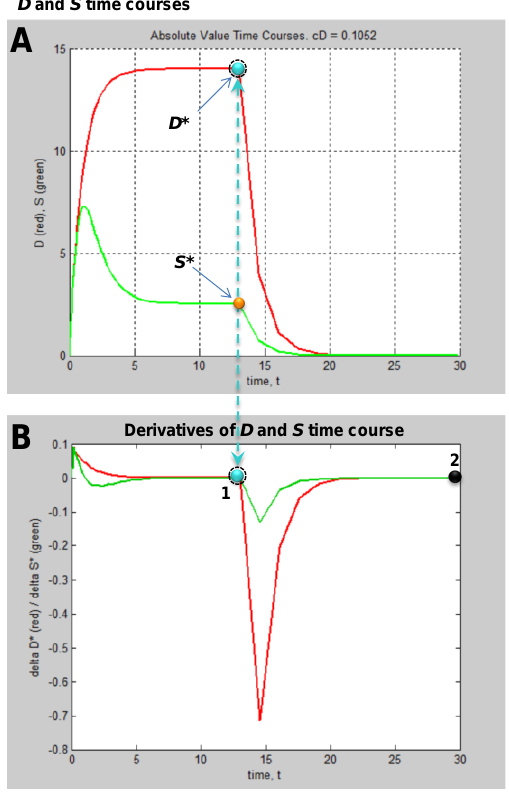
( A ) D (red) and S (green) time courses marked on Figure 6. ( B ) Derivative plots of D (red) and S (green) time courses in panel A. Blue dashed line links the corresponding attractors on time courses to point 1 that indicates where dD / dt = dS / dt = 0. At point 2, dD / dt = dS / dt = 0 because it is the end of the time